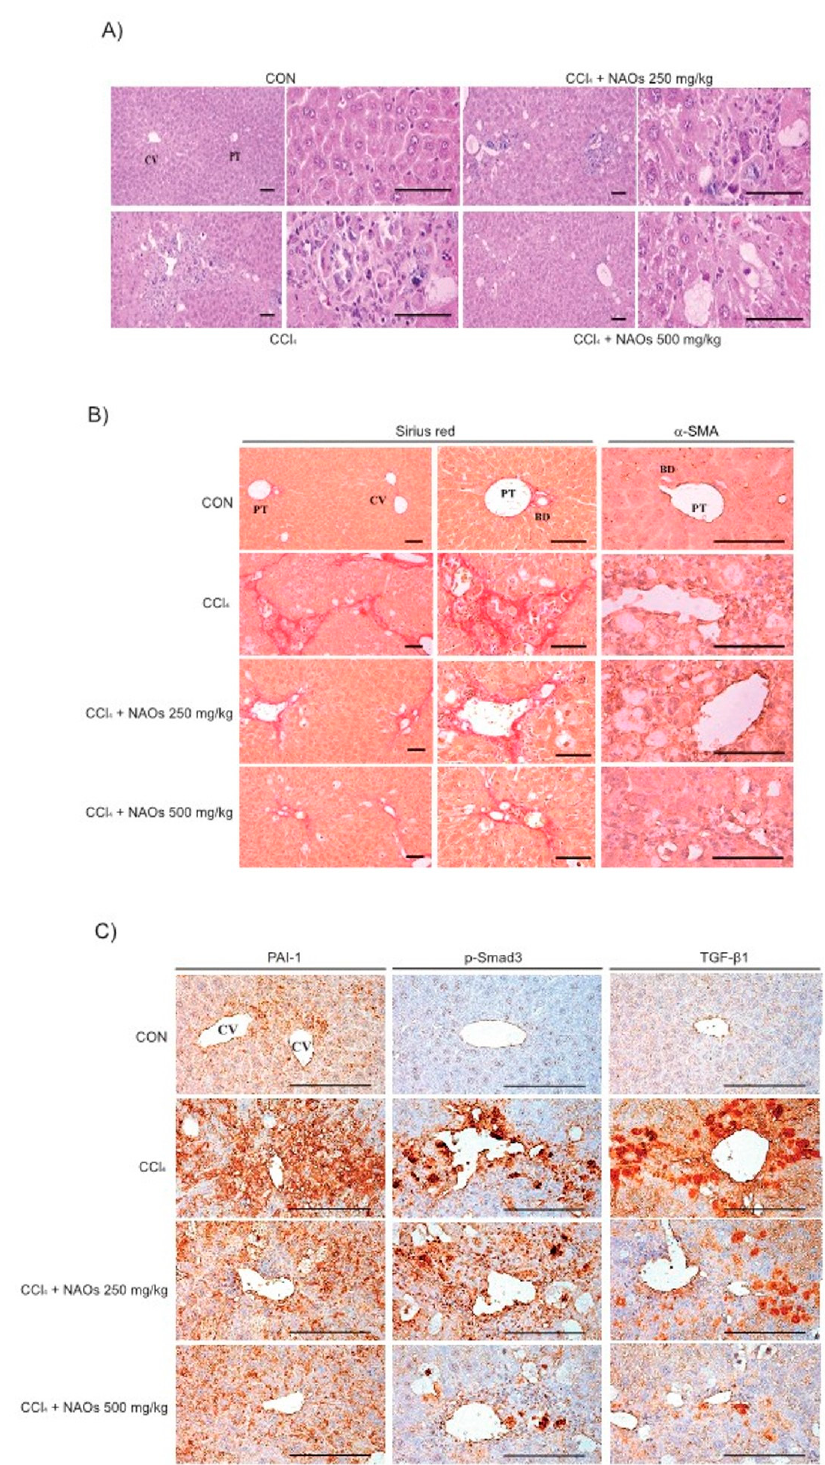
Figure 4. Inhibition of CCl 4 -induced liver fibrosis by neoagarooligosaccharides (NAOs). ( A ) Histopatho- logical changes in mice with CCl 4 -induced subacute liver damage, showing centrilobular necrosis, including ballooning of hepatocytes and infiltration of inflammatory cells. CCl 4 +NAOs treated mice show markedly lowered CCl 4 -induced subacute liver damage as compared to CCl 4 -treated mice. CCl 4 : Carbon tetrachloride, CV: Central vein, PT: Portal trial, Scale bar = 120 µ m. ( B , C ) Sirius red and α -SMA, PAI-1, p-Smad3 and TGF- β 1 immunohistochemical staining of liver from mice treated with CCl 4 or CCl 4 +NAOs for 2 weeks (Scale bar = 120 µ m). CON, vehicle